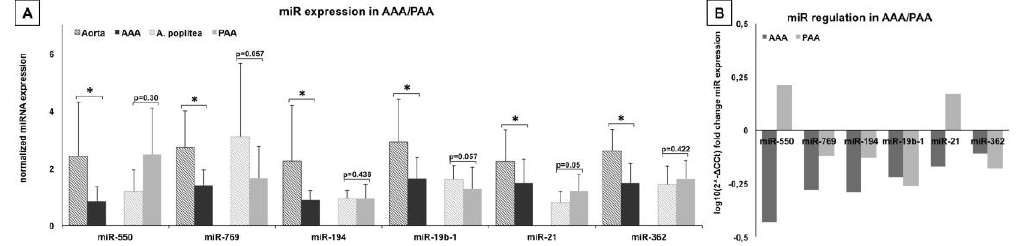
Figure 2. Figure 2. Cont.